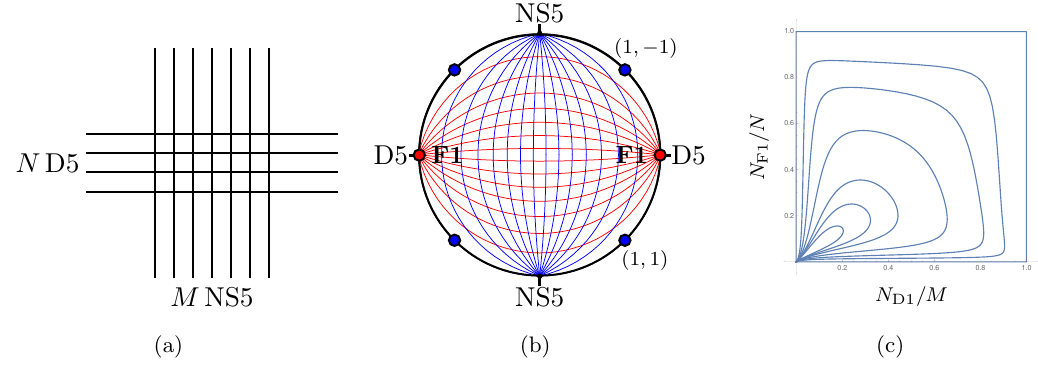
Figure 4 . Left: brane web realizing the gauge theory (2.19). Center: + N;M supergravity solution on the disc, with the 5-brane poles and some of the string embeddings. Along the red/blue curves the D3-brane has constant F1/D1 charge. Right: ( N D1 ; N F1 ) curves, from outer to inner for (cid:8) (cid:9) Im( w ) 2 10 (cid:0) 6 ; 1 ; 1 ; 1 ; 2 ; 3 ; 1 . The Im( w ) = 10 (cid:0) 6 curve traces the boundary of the disc in 20 10 5 5 5 (cid:12)gure 4(b). Each segment of the boundary in (cid:12)gure 4(c) corresponds to a pole in (cid:12)gure 4(b). The F1/D1 charges naturally identify the vertical/horizontal coordinate of the face in which the D3-brane is located in the brane